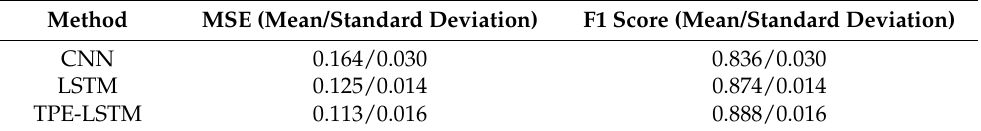
Table 9. The classification performance: the overall results. Aggregated Cleveland + Statlog dataset.